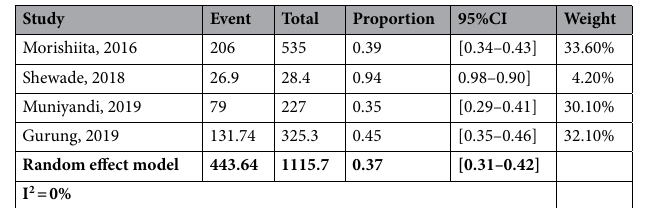
Table 8. Pooled proportion of direct to total costs at catastrophic costs of 20% among passive case finding.